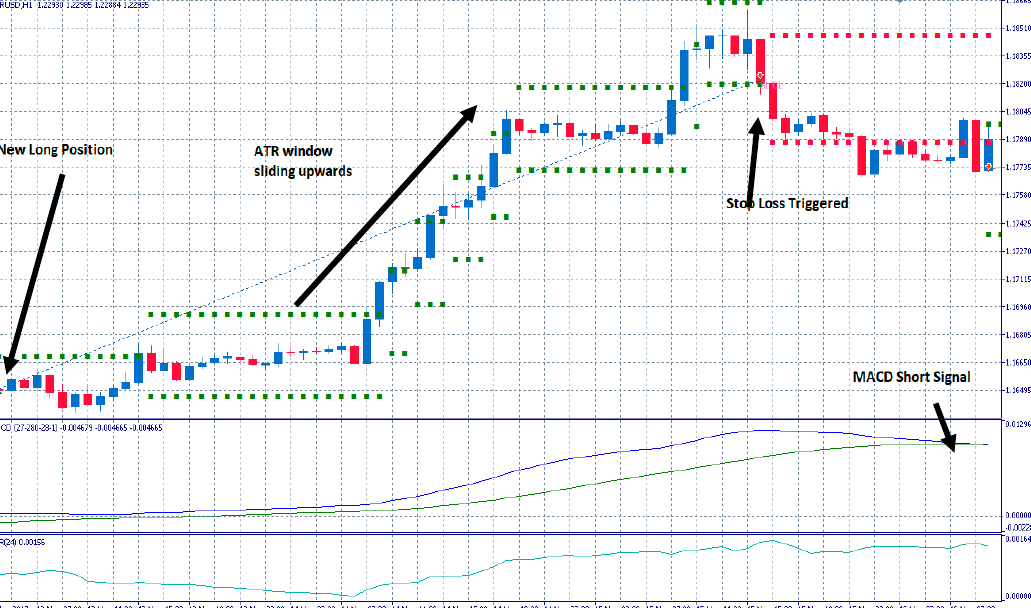
Figure 5. A segment from an MACD Expert Advisor’s trading on EURUSD. The green dots show how the ATR window changes in width as the ATR value changes over time.